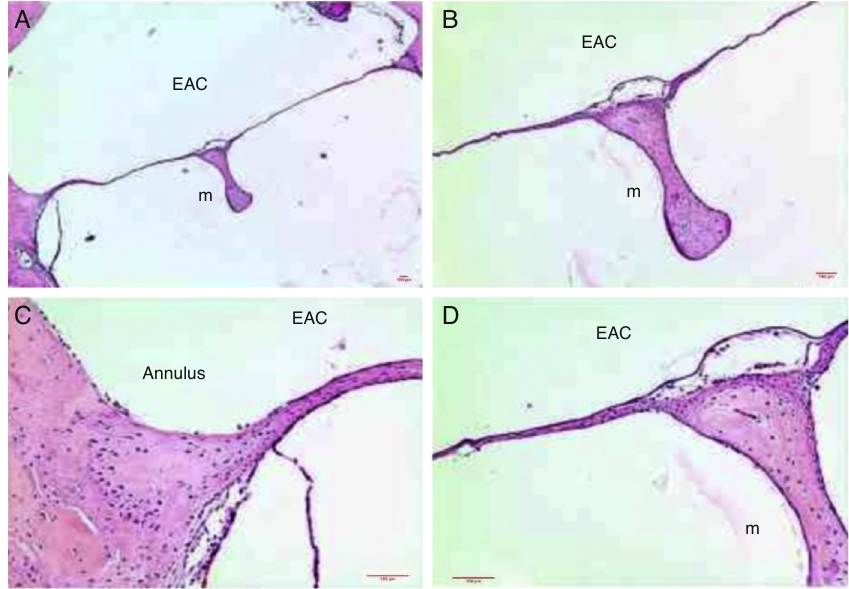
Histological section images of rat TM, stained with hematoxylin---eosin (HE), showing intact TM. EAC, external auditory canal; m, malleus handle; annulus, tympanic annulus. Image (A) shows a magnification of 40 × ; (B) 100 × and (C and D) 200 ×